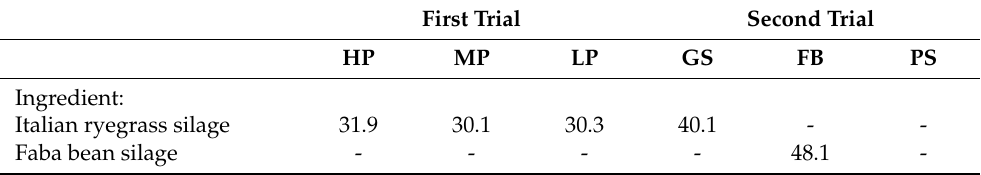
Table 1. Composition of ingredients (% dry matter basis), nutritive value (g/kg DM), and net energy for lactation (Mcal/kg DM) of the total mixed rations. First trial: high protein (HP), medium